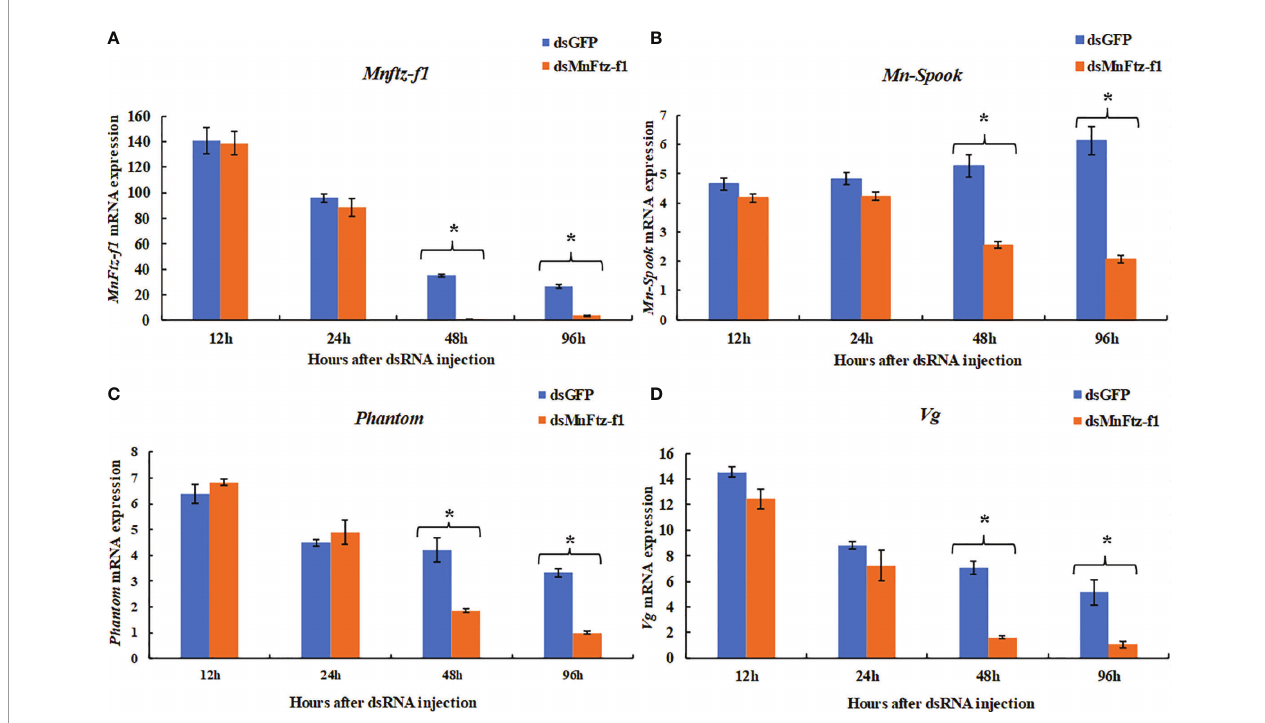
FIGURE 9 | The expression levels of Mnftz-f1 , Mn-Spook , Phantom and Vg after RNAi of Mnftz-f1 . (A) , MnFtz-f1 ; (B) , Mn-Spook ; (C) , Phantom ; (D) , Vg . Data are expressed as mean ± SEM, and the differences were considered to be signi fi cant at P < 0.05 ( * ) by Student ’ s t -test (n = 6).